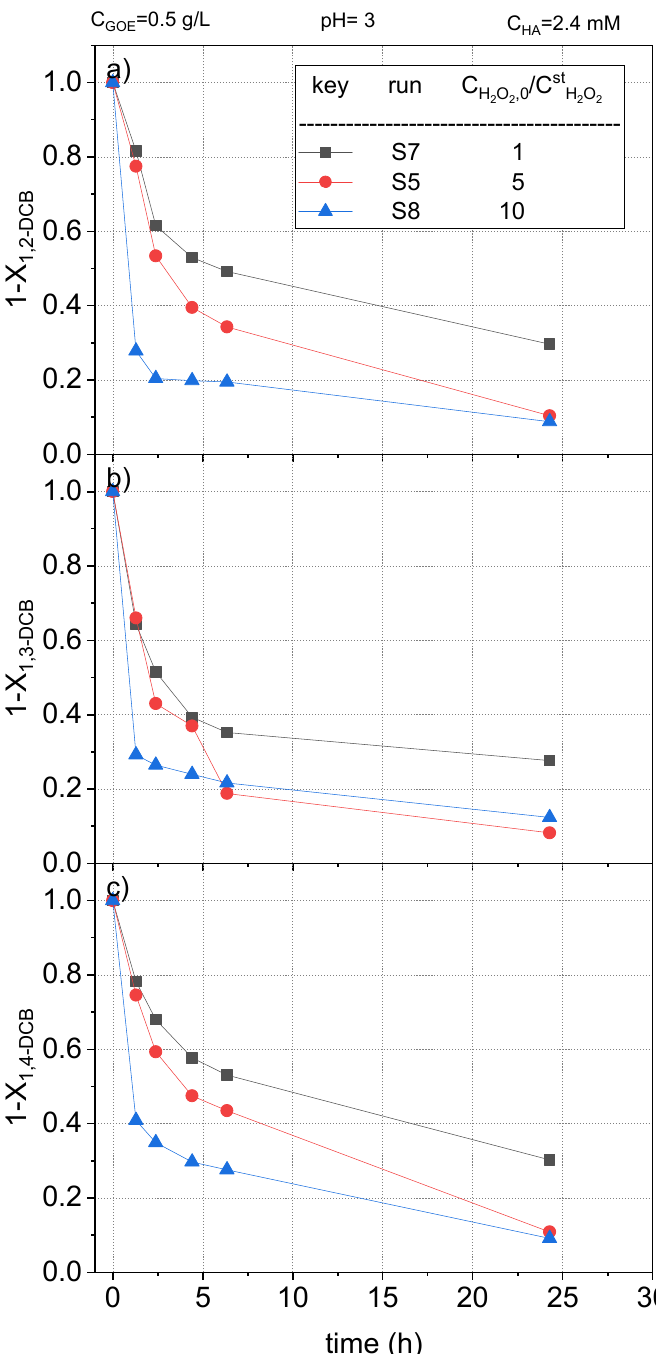
Figure 10. Remaining fractional concentration of ( a ) 1,2-dichlorobenzene ( 1 − X 1,2 − DCB ); ( b ) 1,3-dichlorobenzene ( 1 − X 1,3 − DCB ); and ( c ) 1.4-dichlorobenzene ( 1 − X 1,4 − DCB ) vs. reaction time using di ff erent doses of hydrogen peroxide in a range of 1–10 times the theoretical stoichiometric amount for the complete mineralization of the CBs at pH 0 = 3, C GOE = 0.5 g L (cid:2879)(cid:2869) , and 𝐶 (cid:3009)(cid:3002) = 2.4 𝑚𝑀 , at room temperature (controlled at 22 °C).